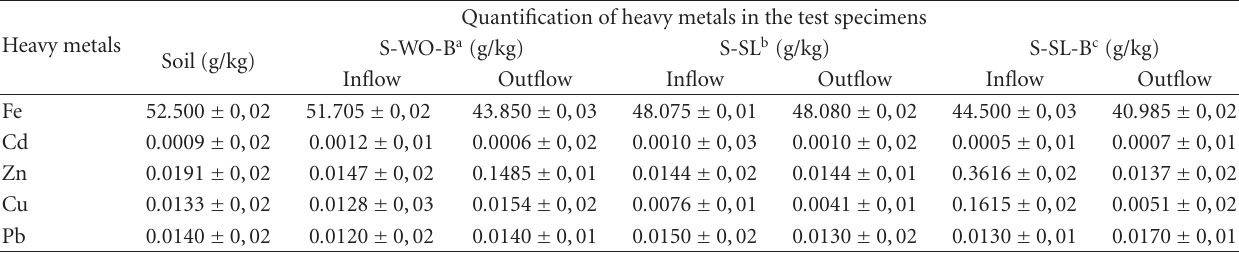
Table 5: Release of metals from test specimens before and after percolation of the